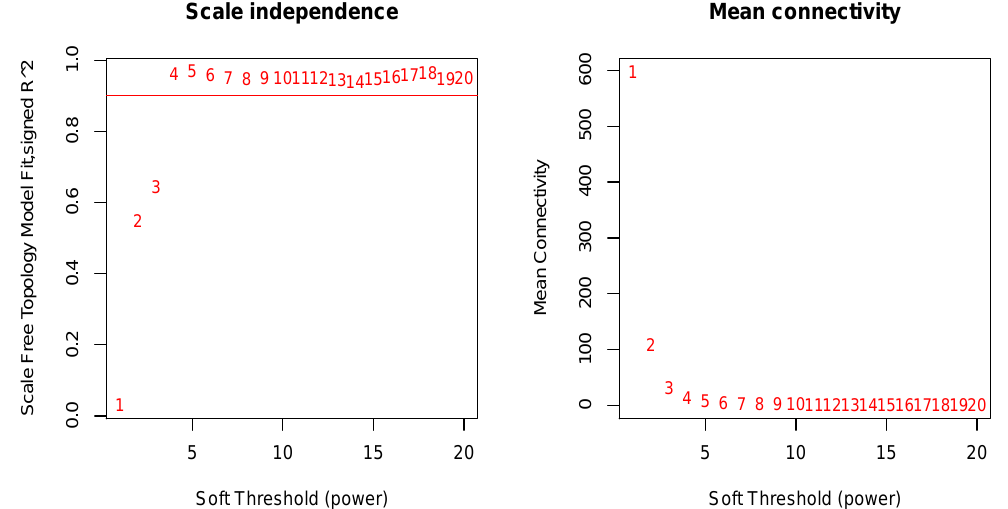
Figure A3. Considering the correlation coefficient R 2 in the scale-free network fitting process and the mean connectivity in the scale-free network model, we selected 4 as the power value.